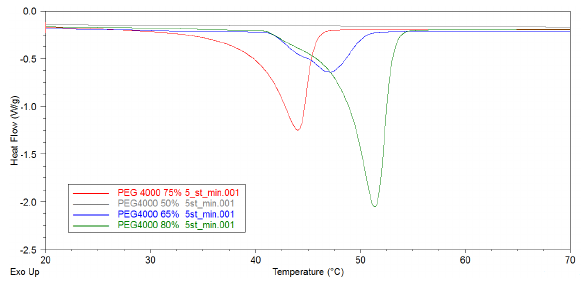
Figure 5. DSC results- curves for materials with different PEG4000 ratio: 50%(grey), 65% (blue), 75% (red), 80%(green).